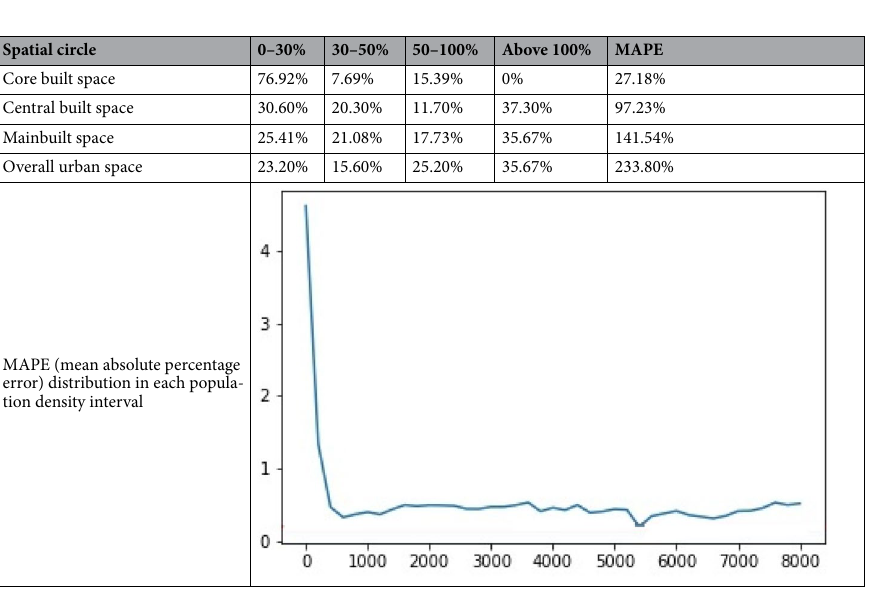
Table 3. Distribution proportion of MAPE in different space areas. Source Author made.